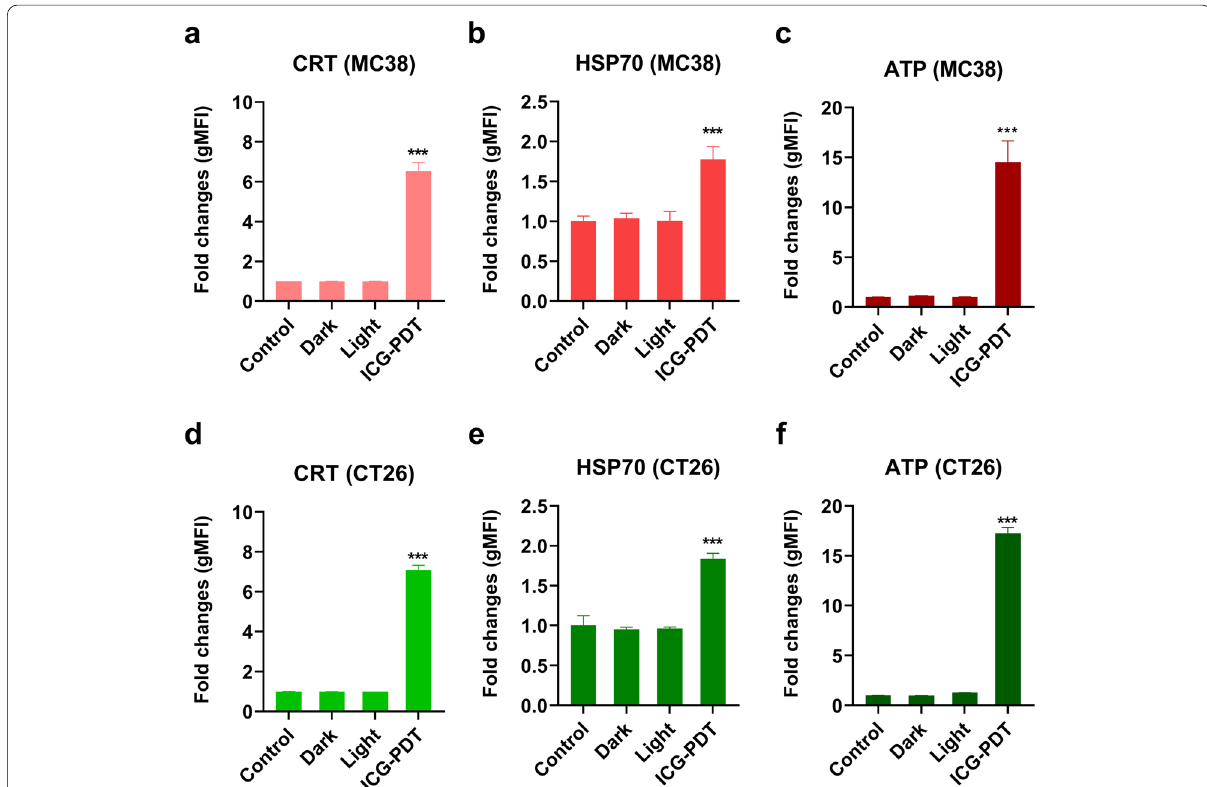
Fig. 3 ICG-PDT-induced cell death in CRC cancer cells is associated with CRT and HSP70 exposure on the cell surface and ATP secretion. Fold change quantification of flow cytometry analysis of CRT exposure at the ( a ) MC38 cell surface and ( d ) CT26 cell surface of DAPI negative cells. Cells were harvested after 2 h of treatment with either ICG-PDT (irradiation by 808 nm laser was performed at 500 mW/cm 2 for a total of 125 J/cm